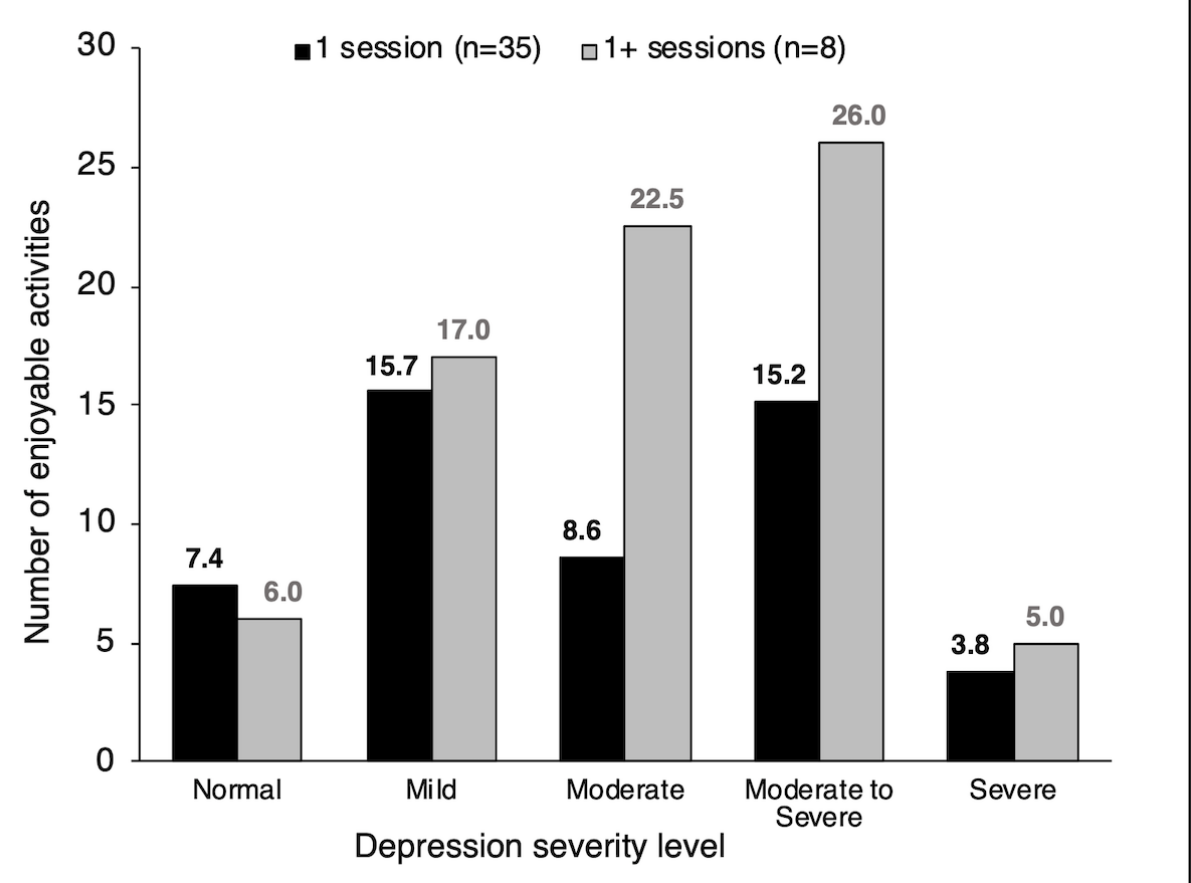
Figure 7. Mean number of activities selected by those who completed one versus multiple sessions based on Patient Health Questionaire-9 depression